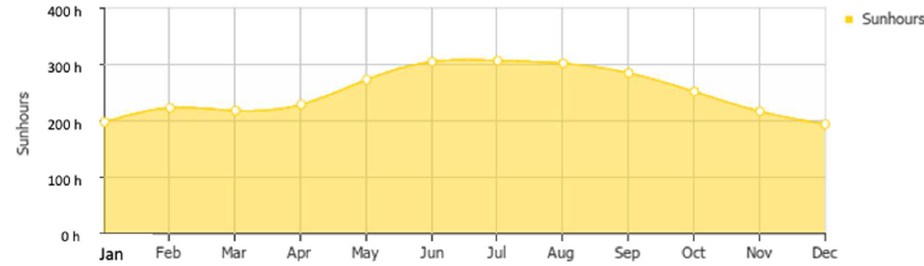
Figure 2. Average monthly sunshine hours in Kuwait [12].